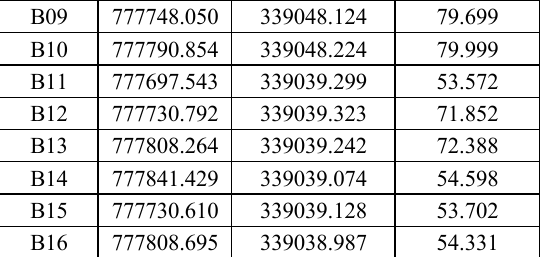
Table 2. Results of Control Points using UAV method.